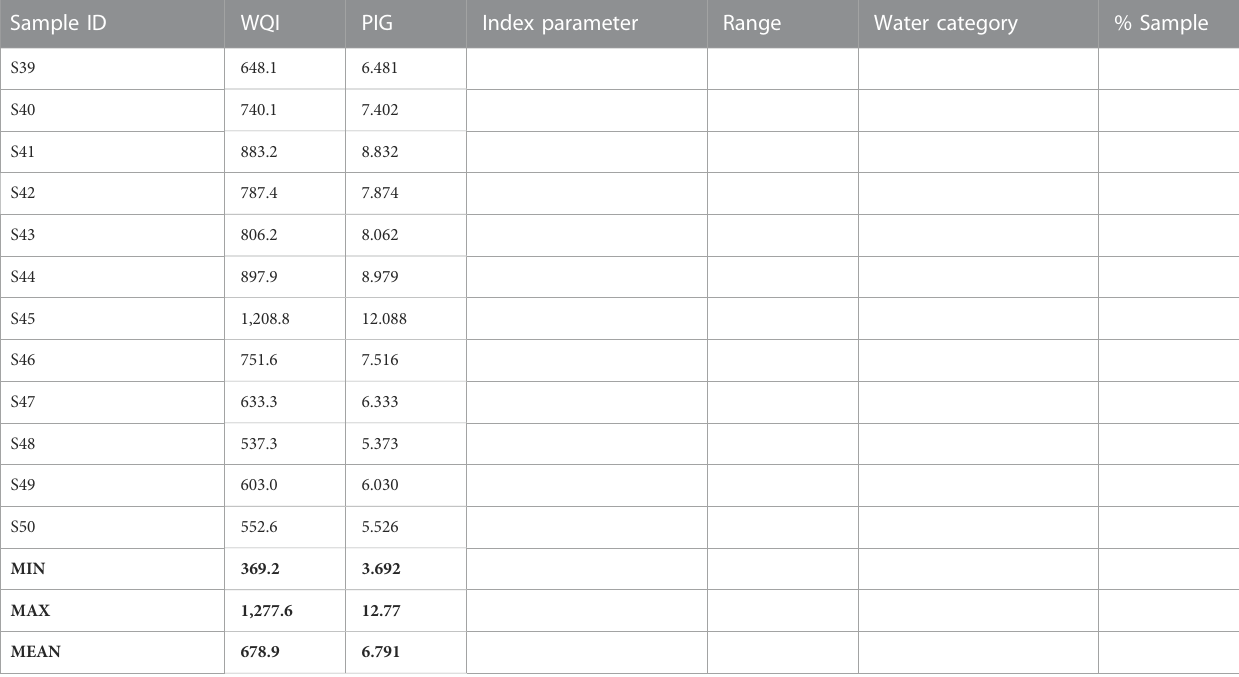
TABLE 5 ( Continued ) Summary statistical results of WQI and PIG and their rating